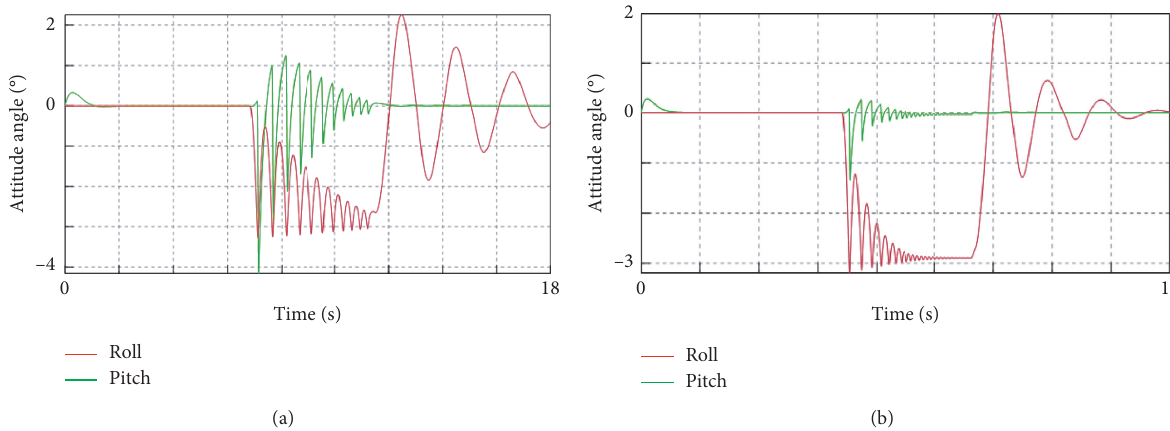
Figure 16: Changes of the attitude angle when the center of mass is (a) 1.5 m and (b) 1.1 m below the axis of the driving wheel.